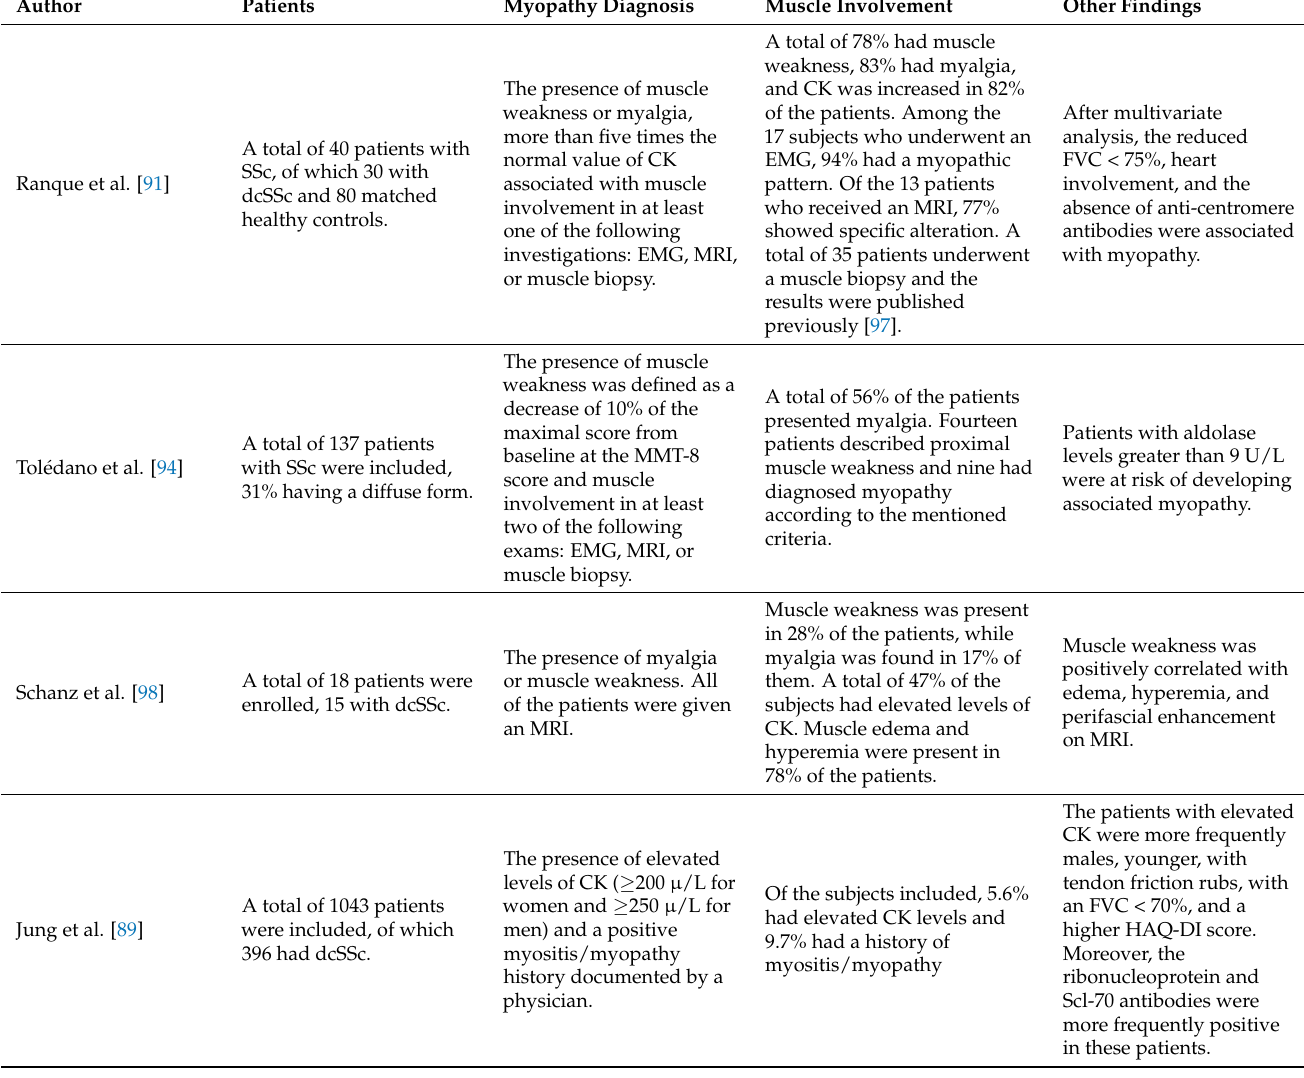
Table 2. Skeletal muscle involvement in SSc as reported by previous studies: clinical and laboratory